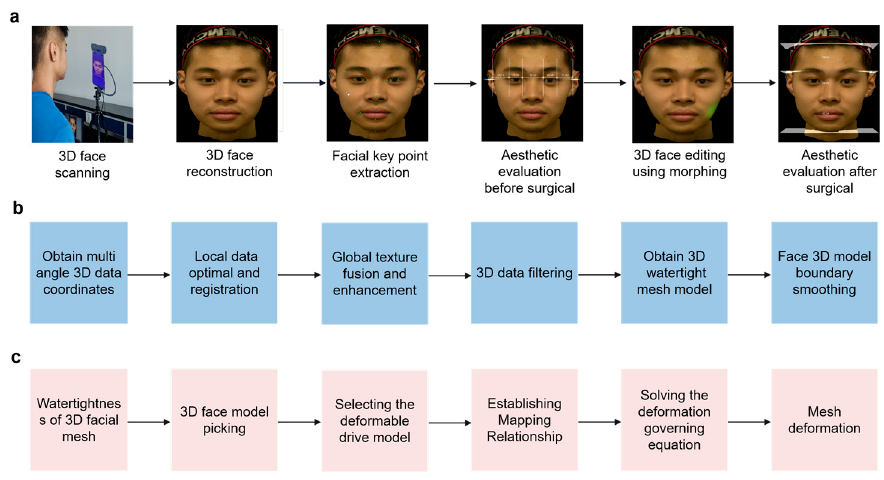
Figure 1. The workflow of proposed facial plastic surgery simulation